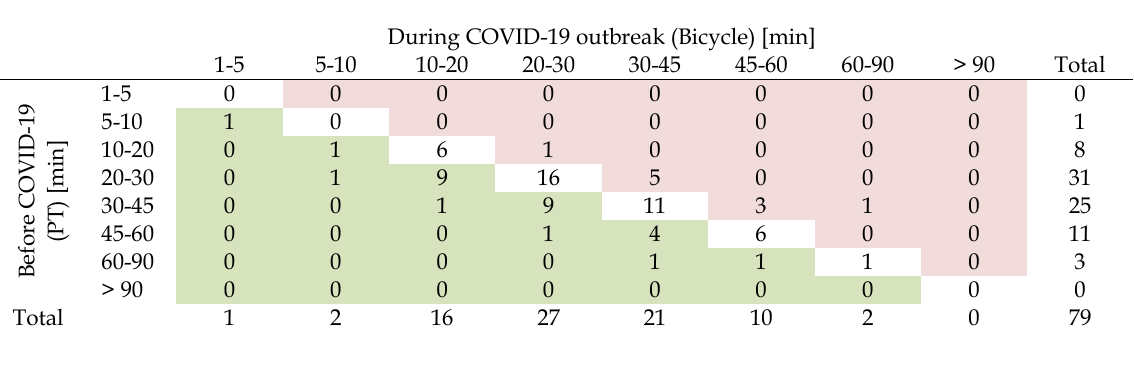
Cross-table of one-way commuting duration before and during COVID-19: public transport to bicycle